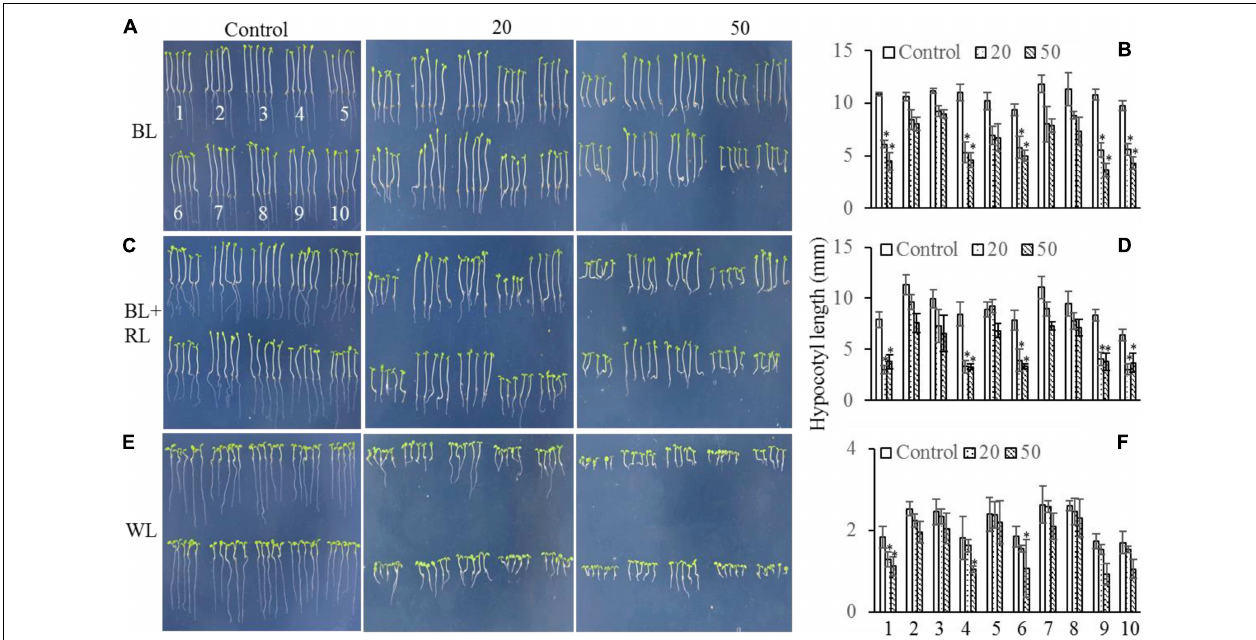
FIGURE 5 | Hypocotyl elongation of WT and mutant plants under various light conditions and treated with 0, 20, or 50 µ mol L − 1 GR24. (A,C,E) Phenotypes of 5-day-old WT and mutant seedlings grown on MS plates with 0, 20, or 50 µ mol L − 1 GR24 under (A) 10 µ mol m − 2 s − 1 blue light (BL), (C) 10 µ mol m − 2 s − 1 blue light plus 10 µ mol m − 2 s − 1 red light (BL + RL), or (E) 70 µ mol m − 2 s − 1 white light (WL). (B,D,F) Hypocotyl lengths of seedlings in panels (A,C,E), respectively. Each bar represents an average of three experiments (15–20 measurements per experiment) ± SD. ∗ P < 0.05. The seedling identifiers are as follows: 1, WT; 2, max2-2 ;